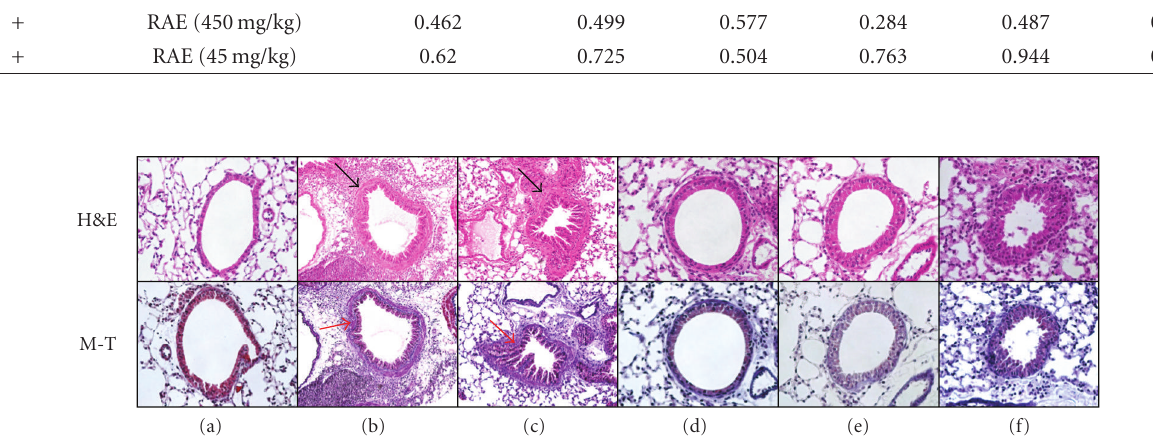
Figure 2: E ff ect of RAE on histology of lung tissue (H&E and Masson trichrome staining) in lung tissues of OVA-induced asthma murine ((a): normal C57BL/6 mice; (b): OVA-induced asthma mice (Control 1); (c): OVA-induced asthma mice (Control 2); (d): OVA-induced asthma mice treated with cyclosporine A (10mg/kg); (e): OVA-induced asthma mice treated with RAE (450mg/kg); (f): OVA-induced asthma mice treated with RAE